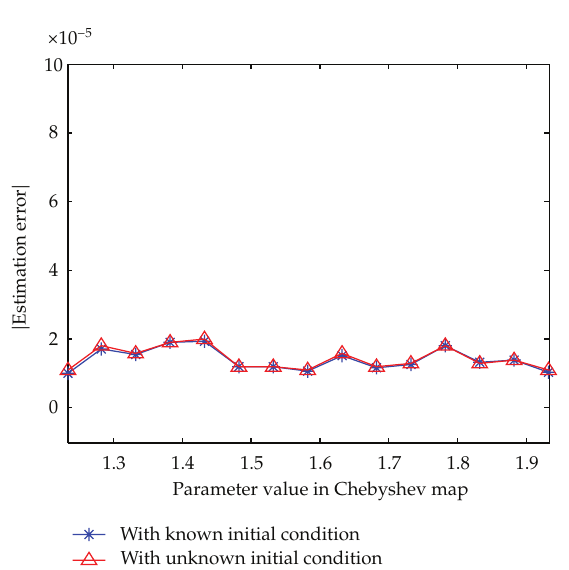
Figure 4: Comparison of improved MVM with and without the knowledge of initial condition, the chaotic map is the Chebyshev